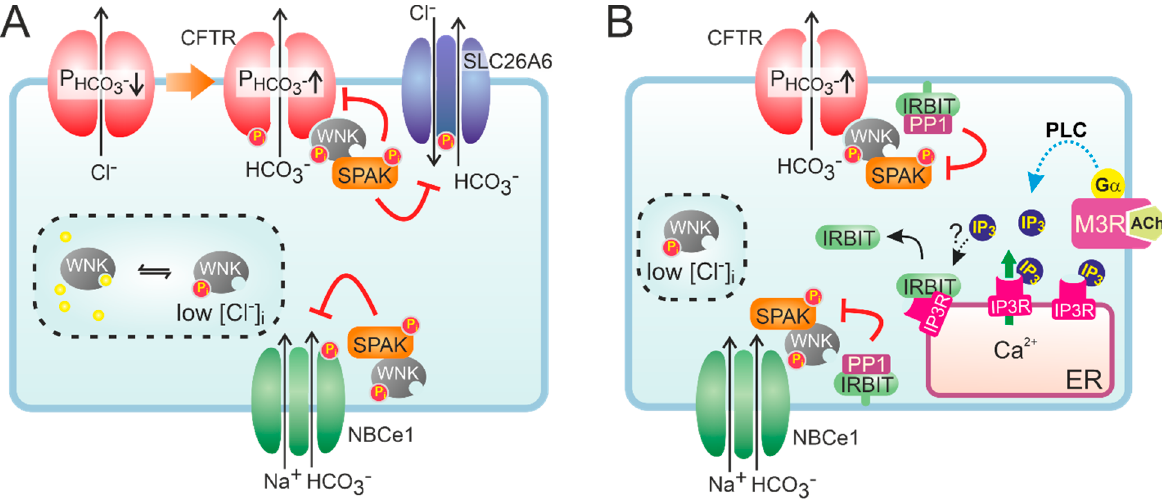
Figure 2. Hypothetical model of the role of WNK and IRBIT in ductal HCO 3- secretion. ( A ) Activa- tion of CFTR decreases intracellular Cl - , which relieves the inhibition imposed by Cl - on WNK and stimulates auto-phosphorylation of the protein kinase. Activated WNK binds to CFTR and increases the HCO 3- permeability (P) of the channel pore, independent of its protein kinase activity. However, WNK also recruits SPAK, which leads to a phosphorylation-mediated decrease in the cell surface expression of HCO 3- transporters, including CFTR. ( B ) IRBIT is bound to IP 3 receptors (IP3R) on cellular Ca 2+ stores, e.g., the endoplasmic reticulum (ER). Conceivably, IRBIT is displaced from IP3R upon a phospholipase C (PLC)-mediated increase in IP 3 production, after which it translocates to the plasma membrane. Through its PDZ domain, IRBIT anchors to the actin cytoskeleton (not shown) and recruits a protein phosphatase (PP1) to the WNK/SPAK complex. PP1 activity counter- acts SPAK-dependent phosphorylation of HCO 3- transporters, thus stabilizing their expression at the cell surface. IRBIT does not affect the WNK-dependent but rather the SPAK-independent in- crease in CFTR HCO 3- permeability.